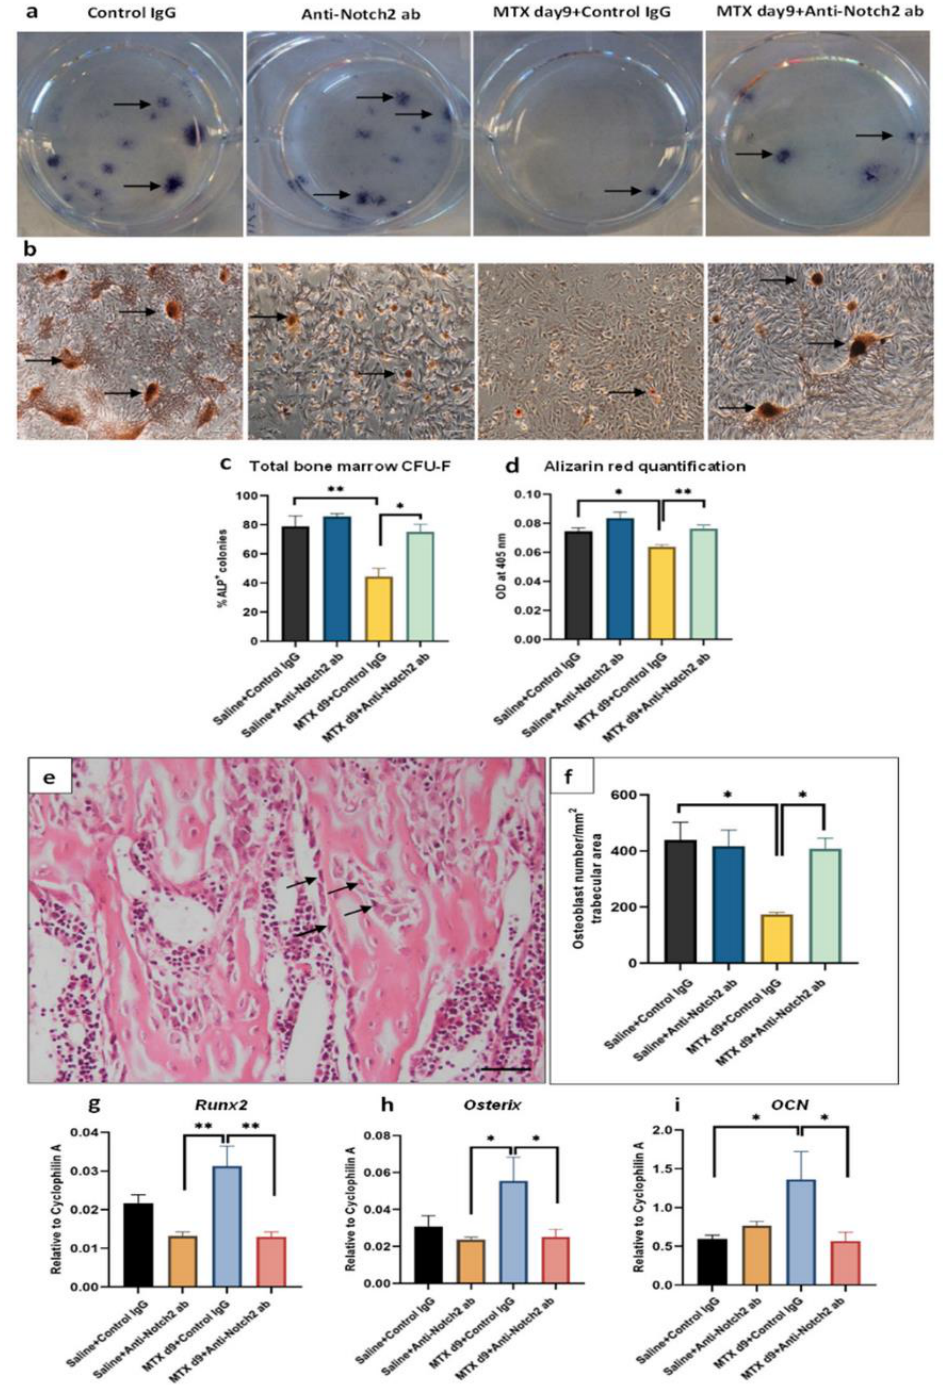
Figure 6. Treatment effects on osteogenic potential of bone marrow stromal cells (BMSCs), osteoblast density at secondary spongiosa and mRNA expression of osteogenesis regulatory genes in the meta- physeal bone. ( a ) Representative CFU-f colonies (arrows) stained positive for alkaline phosphatase (ALP) with BMSCs from different treatment groups; ( b ) representative images of alizarin red-stained mineralised nodules (arrows); scale bar is 200 µ m. ( c ) Treatment effects on numbers of ALP+ CFU-f colonies; ( d ) alizarin red quantification with absorbance reading at 405 nm. ( e ) Location and morphol- ogy of osteoblasts in secondary spongiosa. Arrows highlight cuboidal osteoblasts. Scale bar 50 µ M; ( f ) osteoblast density in tibial secondary spongiosa; treatment effects on mRNA expression in metaphyseal bone of ( g ) Runx2, ( h ) SP7 (Osterix), and ( i ) BGLAP (osteocalcin or OCN); * p < 0.05, ** p <